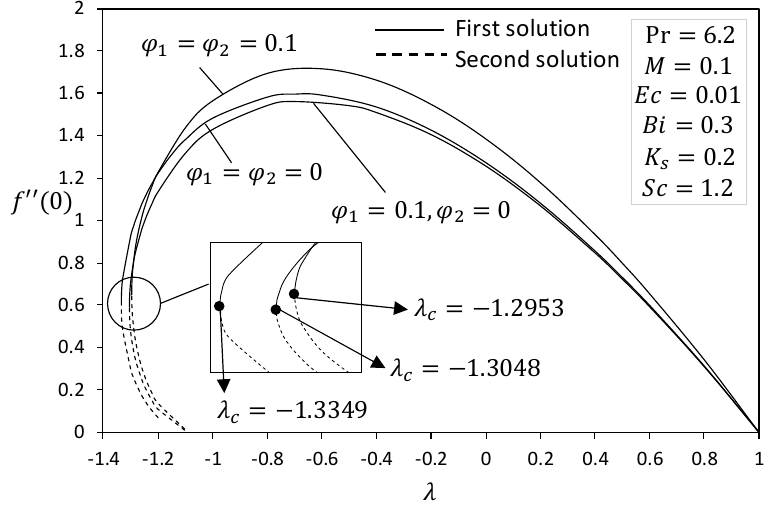
Mathematics 2020 , 8 , x FOR PEER REVIEW